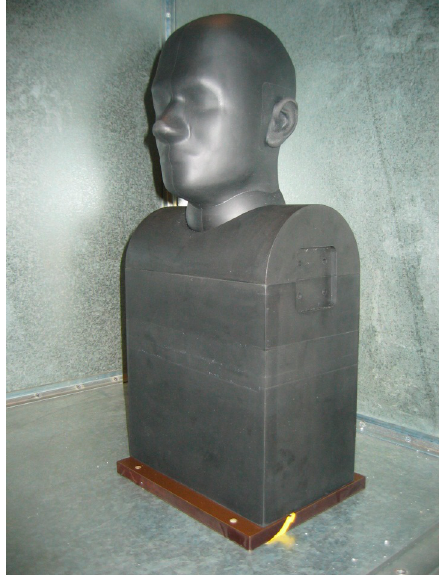
Figure 3. The generic head and torso solid anthropomorphic phantom.